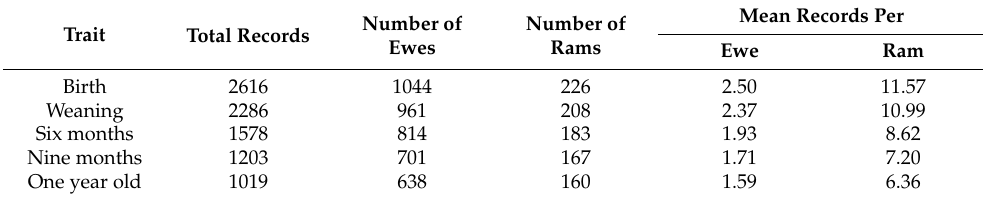
Table 1. Data structure on growth